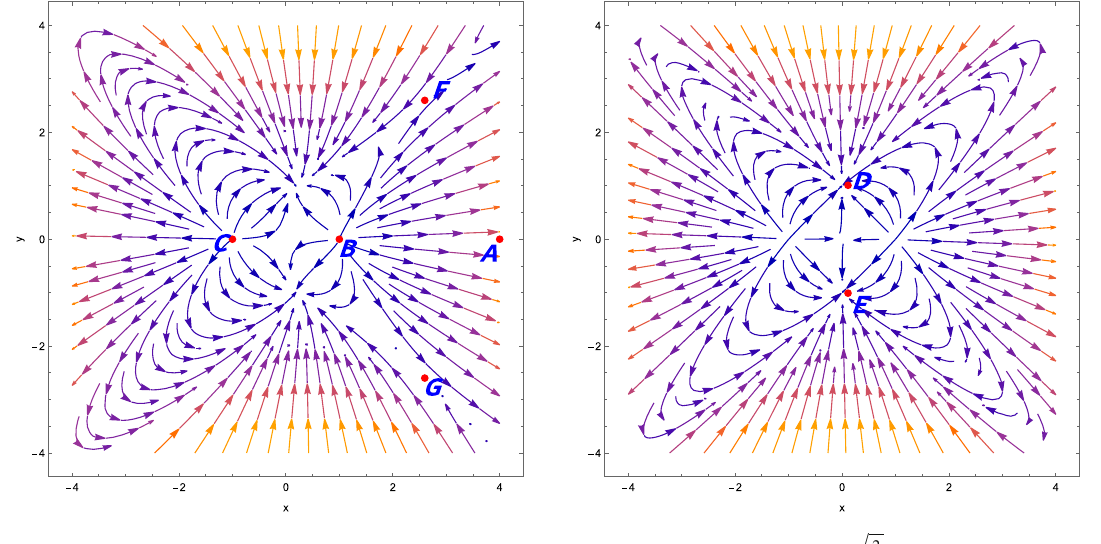
Fig. 3 Phase portrait for dynamical system in Eqs. (64–68), the left plot is for u = 0, ρ = 0, τ = 1, λ = values u = 0, ρ = 0, ζ = 1